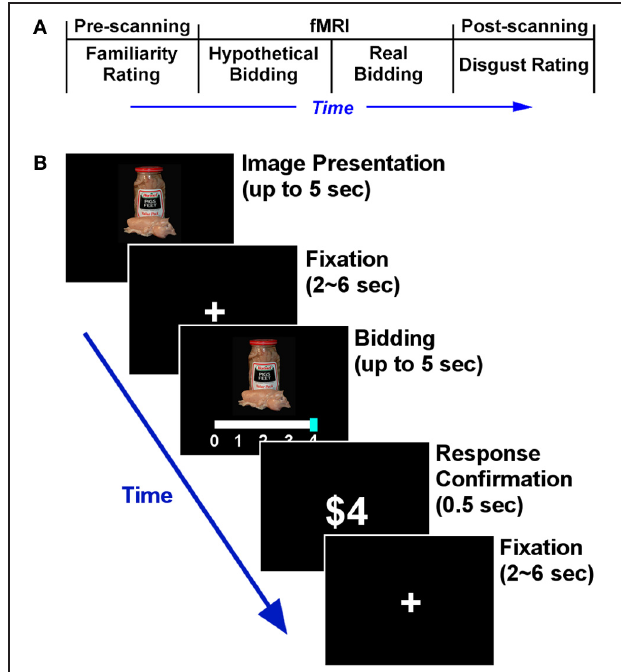
FIGURE 1 | Experimental design. (A) Timeline of the entire experiment. (B) Time course of an individual trial in the scanning part. The structures of the hypothetical and real bidding trials were identical. All 50 food items were repeated across the two bidding blocks. During the food image presentation, subjects were asked to press any button as soon as they had decided how much to bid. Subjects submitted their bid using a sliding scale. The initial position of the bidding cursor (anchor) was randomized in every trial in order to avoid any potential anchoring effects (Tversky and Kahneman,